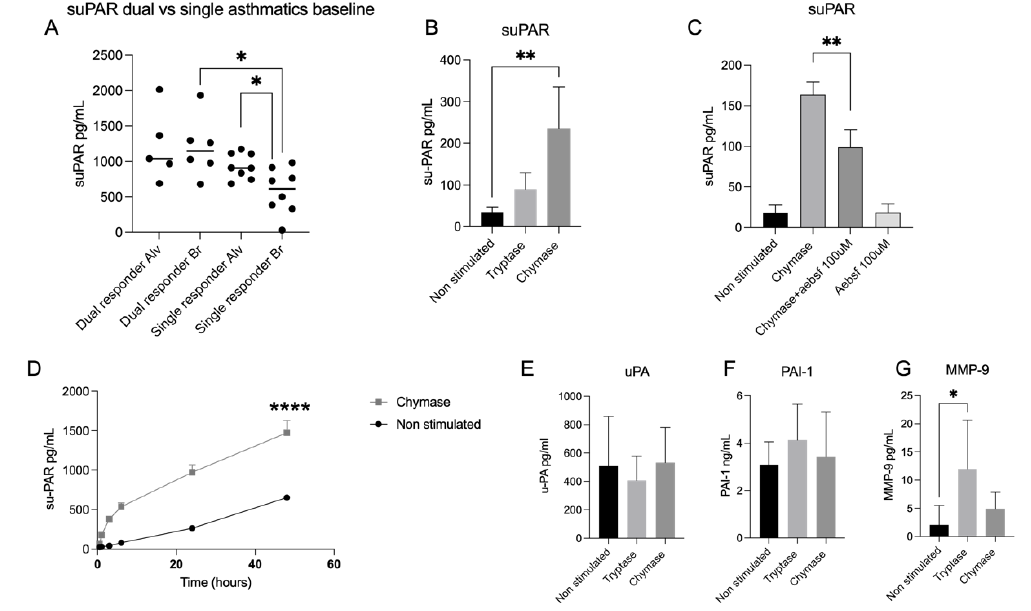
Figure 4. ELISA analysis revealed an increased presence of suPAR in dual responders compared to single responders and higher levels of suPAR in alveolar lavage fractions compared to bronchial BAL in single asthmatic responders ( A ). Chymase stimulated alveolar epithelial cells had increased levels of suPAR compared to non-stimulated cells ( B ) and the chymase effect was confirmed using AEBSF serine protease inhibitor ( C ). The increased liberation of suPAR remained over time (48 h) in chymase stimulated cells compared to non-stimulated cells ( D ). There was no statistical difference between any of the groups regarding the supernatant content of uPA ( E ) or PAI-1 ( F ). Tryptase stimulated cells had a higher protein expression of MMP-9 compared to non-stimulated cells ( G ). Statistical significance between non-stimulated and chymase stimulated cells at different time points was tested using two-way ANOVA with Šidák’s multiple comparison test. Statistical significance between non-stimulated and tryptase stimulated cells and nonstimulated and chymase stimulated cells was tested using the Mann–Whitney test. Data represent the mean (SD) and are based on 5 technical repeats. * p < 0.05, ** p < 0.01, **** p < 0.0001. For dual responders alveolar fraction n = 5, dual responders bronchial fraction n = 6 and single responders alveolar and bronchial fractions n = 8. Br = Bronchial fraction. Alv = Alveolar